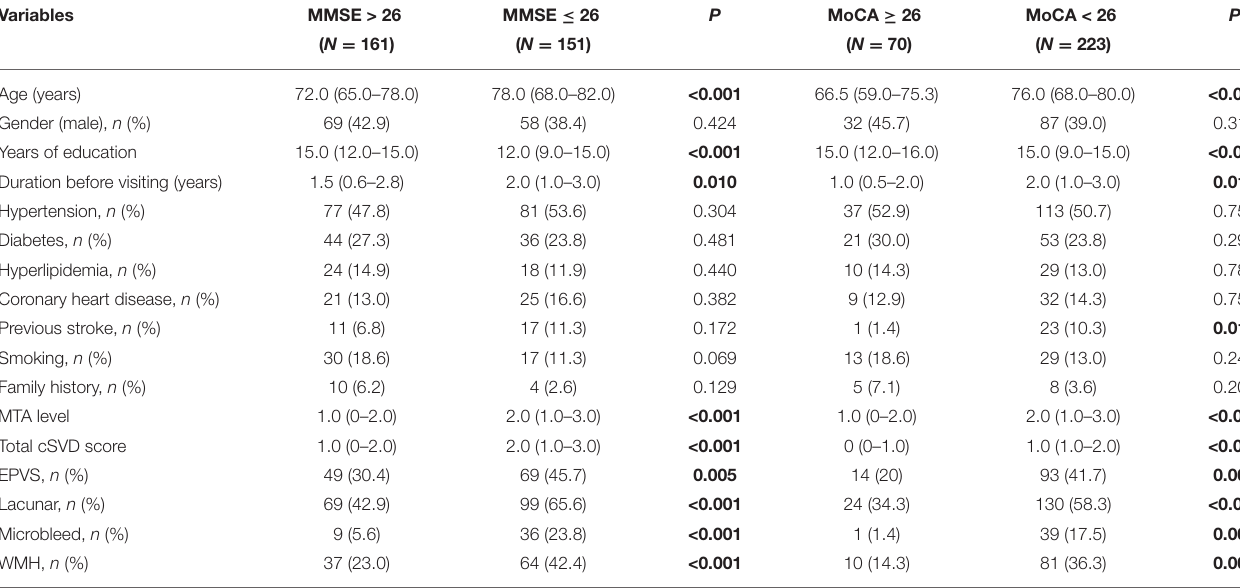
TABLE 4 | Demographic, clinical, and MRI characteristics of patients in different cognition status